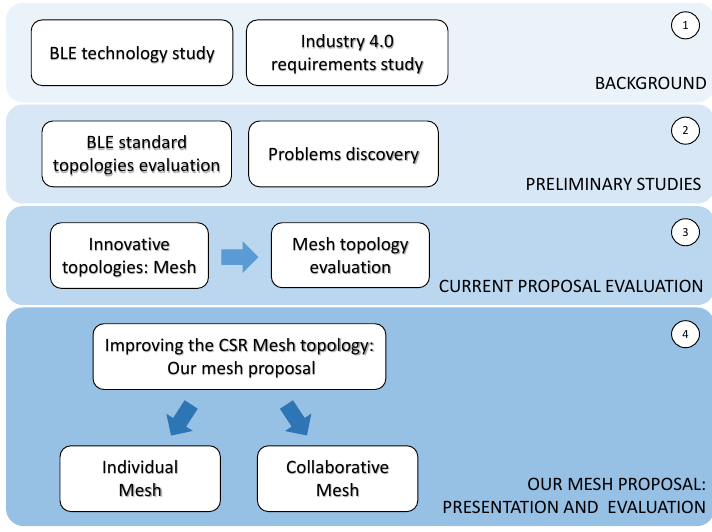
Figure 5. Paper road